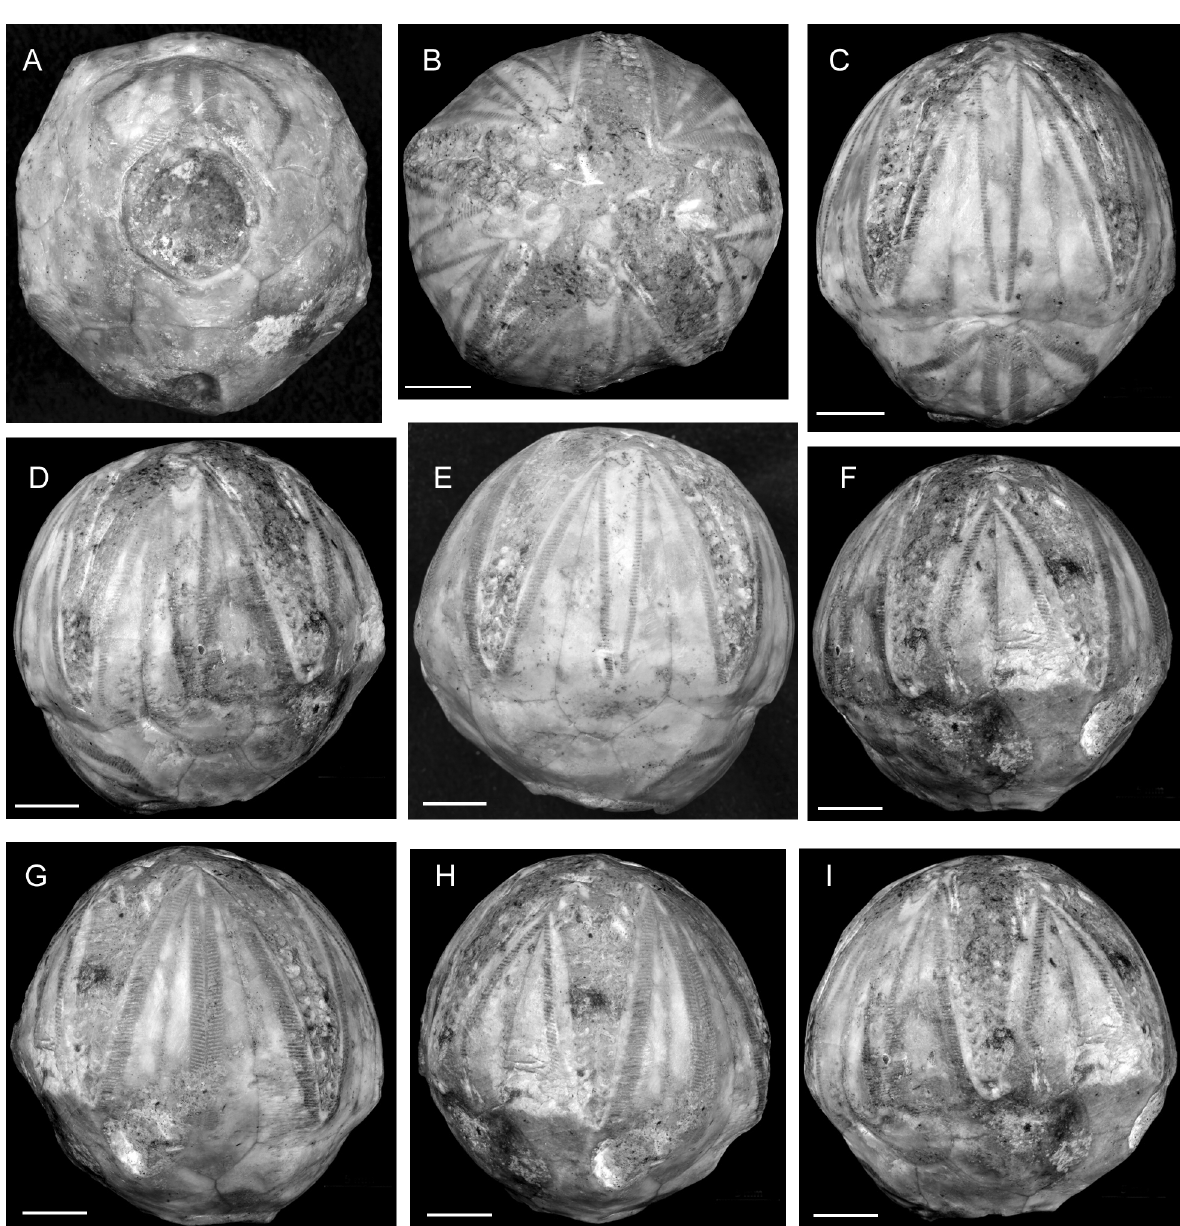
Fig. 1. Photographs of Cystoblastus kokeni Jaekel, TUG 1086­3, Kukruse Regional Stage (Viivikonna Formation), Tallinn, Estonia. A , basal view showing recess for stem, two basal pectinirhombs (above) and periproct (below). B , oral view showing five ambulacra. C , anterior lateral view showing basal pectinirhombs and short B2:L2 suture, thus IL1 with half rhomb on right is not in contact with IL2 with half rhomb on the left. D , lateral view centred on B1:L1 suture separating IL5 (right) from IL1 (left). E , lateral view showing B3:L3 suture separating IL2 (right) from IL3 (left). F , lateral view showing R4:R6 suture with no lateral plate between the radials. G , lateral view showing L4 which comes to a point adorally (top). H , posterior lateral view showing small, circular periproct (below). I , lateral view centred on ambulacrum C showing traces of facets below. Specimen uncoated to enhance plate sutures. All scale bars = 5